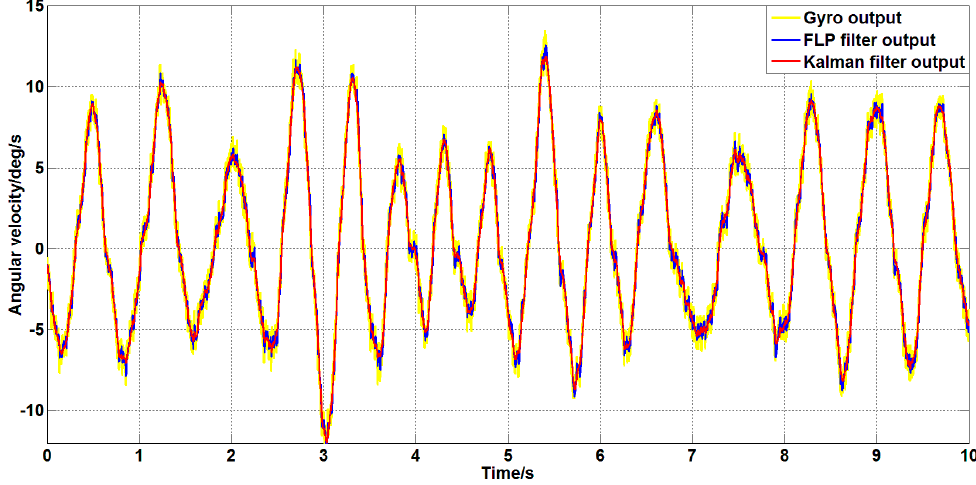
Figure 22. Filtering effect of different filtering algorithms under random motion.